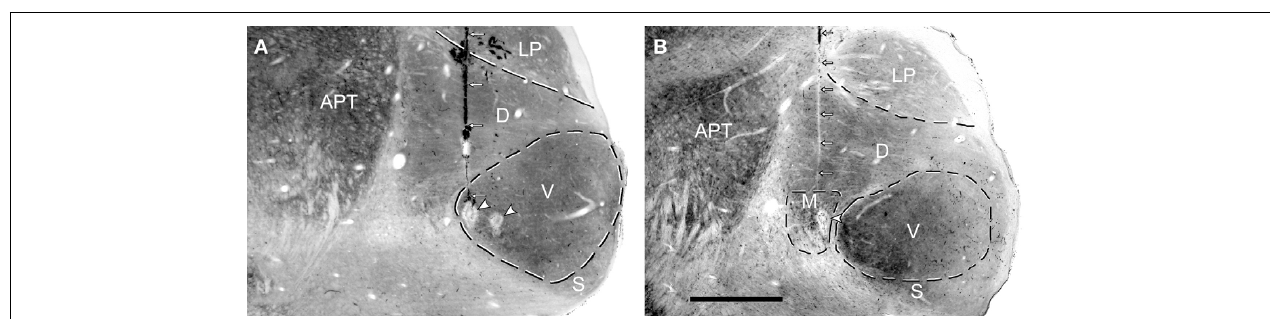
FIGURE 6 | Coronal sections through the medial geniculate body (MGB) that have been stained for cytochrome oxidase activity. High enzyme activity occurs in the anterior pretectal nucleus (APT) and in the ventral (V) division of the MGB while relatively low levels occur in the lateroposterior (LP) nucleus and shell division of the MGB. The dorsal division (D) of the MGB has intermediate enzyme activity while the medial division (M) of the MGB has a striated appearance because of bundles of fibers. (A) A single electrode track (small white arrows) filled with darkly stained red blood